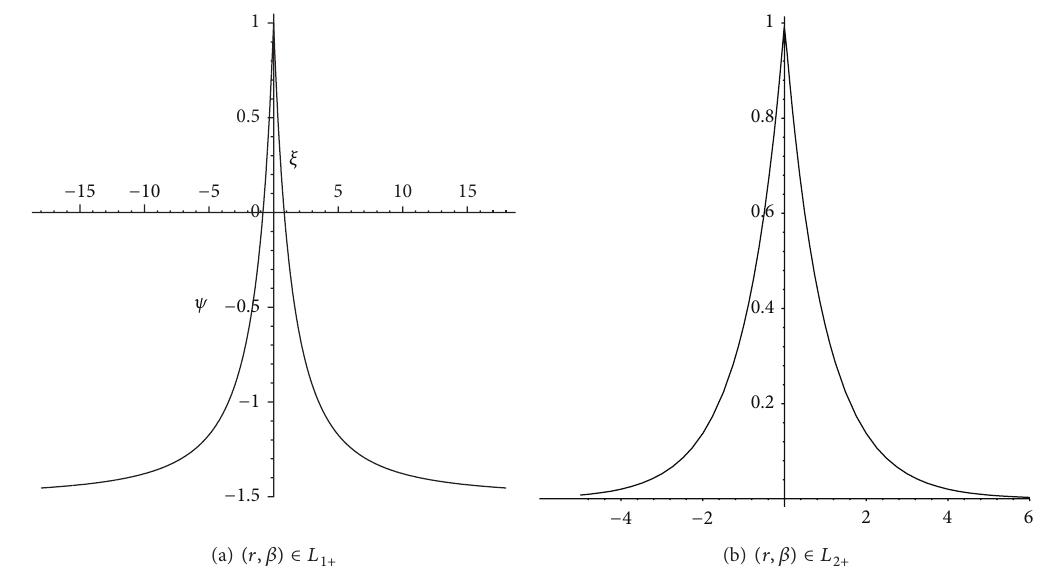
Figure 3: The peakon solutions of (8) for 𝛼 < 0